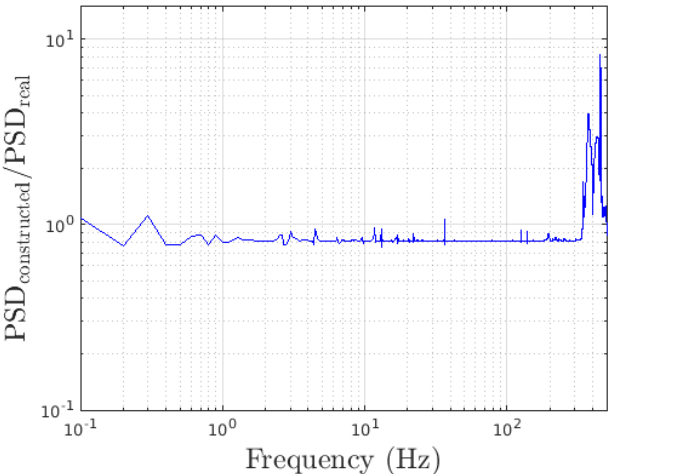
Figure 13. Ratio of the PSD from the expansion and the real PSD from mechanical characterisation of the cryobaffle data. The ratio shows values that fluctuate around 1, implying the validity of the method. Figure 14 shows a comparison of the effective displacement and the original displacements.